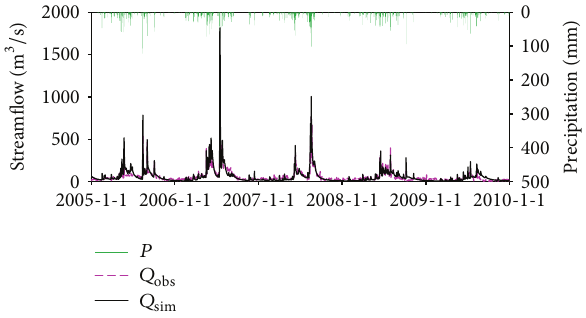
Figure 6: Streamflow simulations at Honglai station, where 𝑃 is is observed streamflow, and 𝑄 precipitation, 𝑄 obs streamflow by BTOPMC.